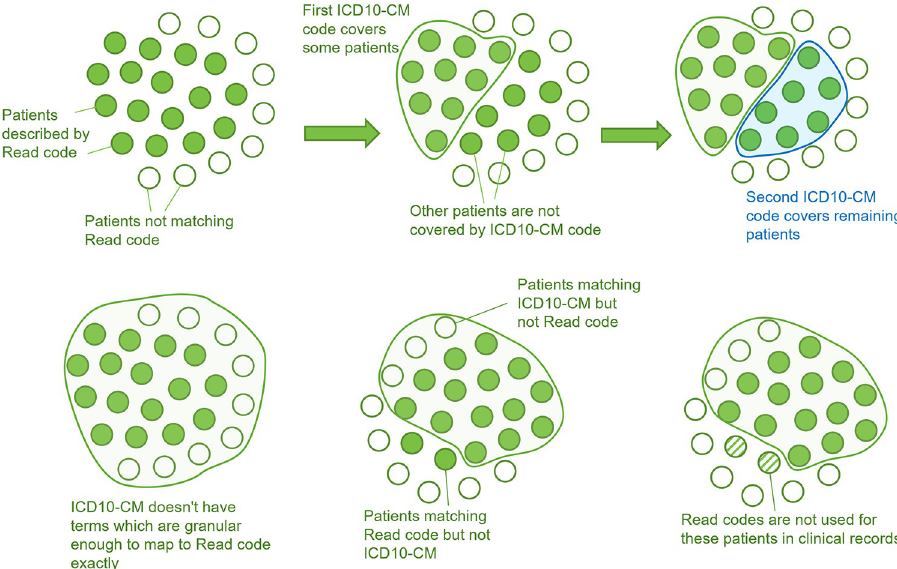
Fig 2. Illustration of term mapping issues due to mismatch between Read code and ICD10-CM ontology. Each circle represents a patient. Patients with Read code are represented by closed green circles. A–one Read code is mapped to several ICD10-CM codes. B–Read code is too specific for any ICD10-CM code, C–populations of patients described by ICD10-CM and Read codes do not overlap perfectly, D–hypothetical situation in which patients’ condition could be described by a Read code, but in clinical practice this code was not